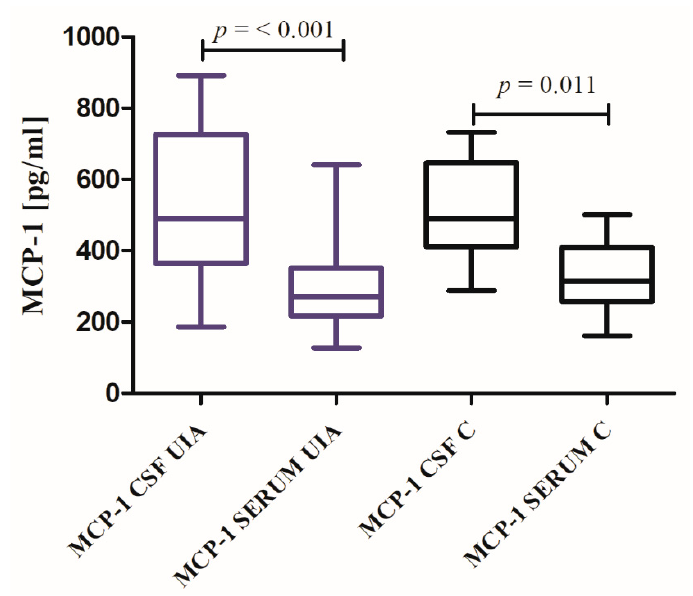
Figure 4. MCP-1 cerebrospinal fluid (CSF) and serum concentrations in unruptured intracranial aneurysm (UIA) patients compared to control group (C).